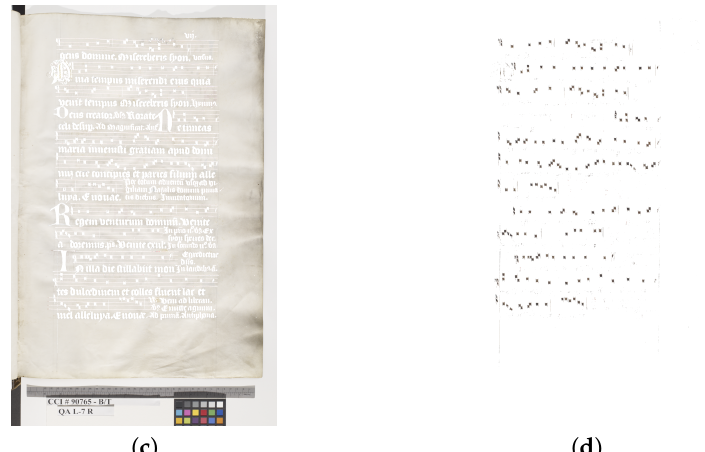
Figure 1. Example of application of the Pixelwise scheme on folio 7r of Salzinnes book. ( a ) Scanned image. ( b ) Extracted staves. ( c ) Image background. ( d ) Musical symbols